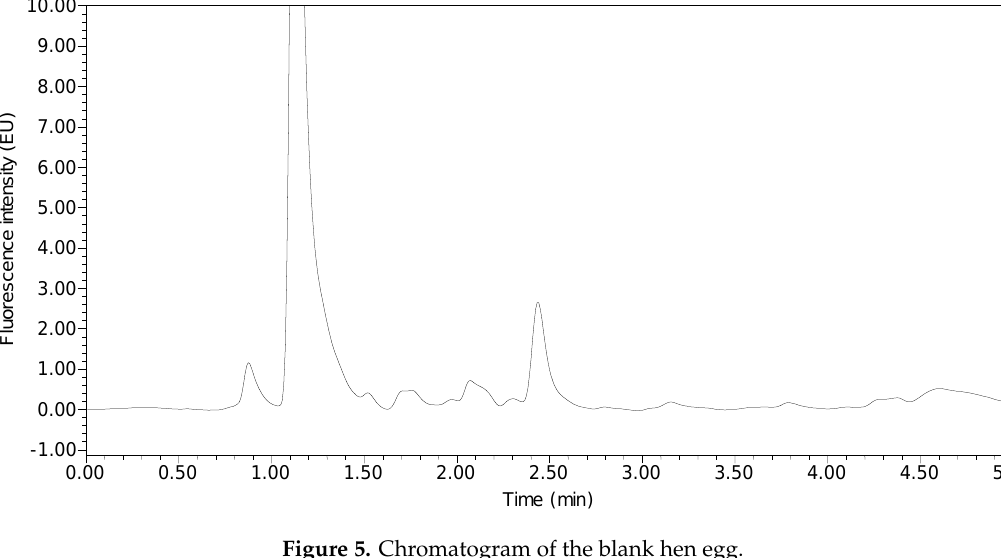
Figure 5. Chromatogram of the blank hen egg.